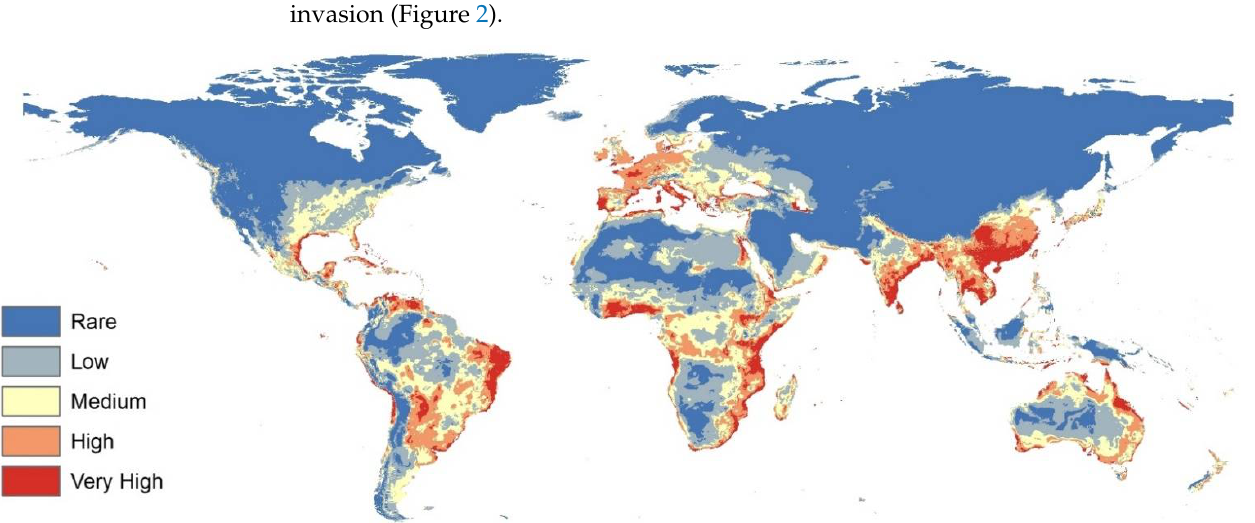
Figure 4 . Calibration maps showing gain and loss in habitat suitability of A . niger through the four future scenarios against the current status with threshold (>0.5): ( A ) 2050 for RCP 2.6; ( B ) 2050 for RCP 8.5; ( C ) 2070 for RCP 2.6, and ( D ) 2070 for RCP 8.5. 4 . Discussion In the last few years, Aspergillosis impose as a medical emergency issue as a result of the COVID-19 pandemic and its connection as a secondary infection in many cases throughout the world [33,34]. Severe acute respiratory damage as a result of COVID-19 infection-induced pulmonary epithelium degradation enables Aspergillus invasion and leads to death in many cases, especially for aged patients [35]. With the wide spread of A. niger through the world and the continuation of COVID-19 pandemic, the need for a clear distribution map of this species becomes more urgent not only for the current situation but also for the future status under climate change. The present work forms a step in this direction for a better understanding of the hab- itat requirements of A . niger and how it will respond to climate change. The modeling of this species of fungi was conducted by Shabani, Kumar, and Esmaeili in 2015 using CLIMEX, and only maximum and minimum temperature as parameters for the model [3]. The Maxent modeling has many advantages on CLIMEX as a modeling tool; also, the use of Bioclimatological data which implemented the connection of temperature and